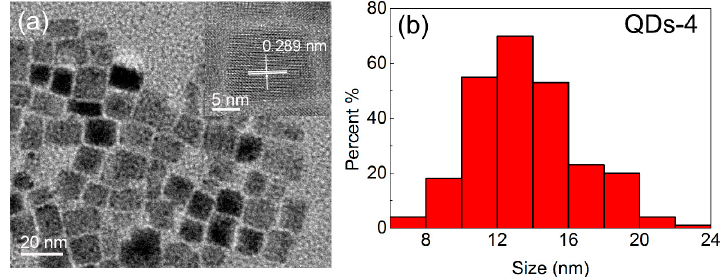
Figure A2. ( a ) TEM image and ( b ) particle size statistical chart of QDs-4.